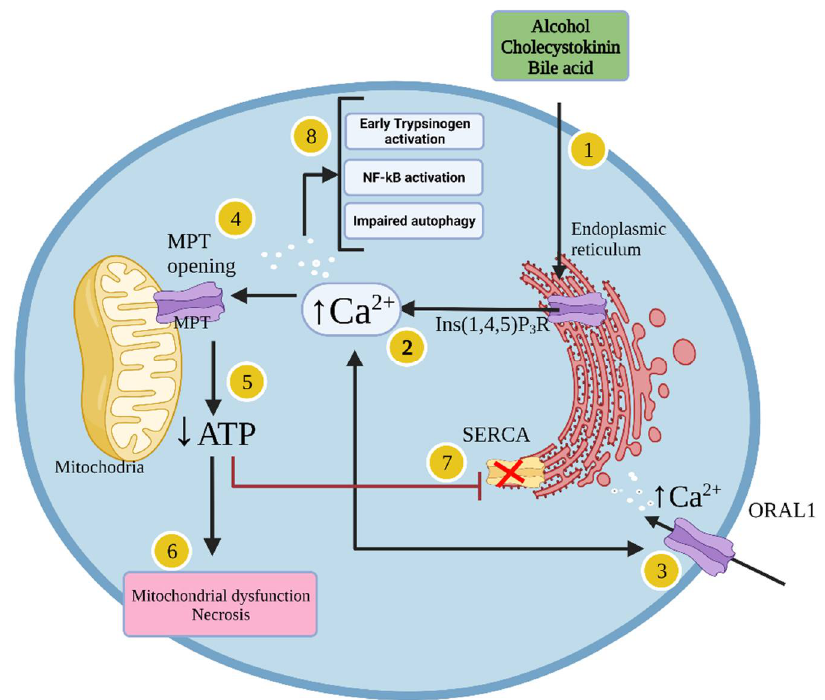
Figure 1. Mechanism of pancreatic acinar cell death induced by pancreatitis. In pancreatic cells, al- cohol, cholecystokinin (CCK) and bile acids lead to activation of inositol 1,4,5-trisphosphate receptor